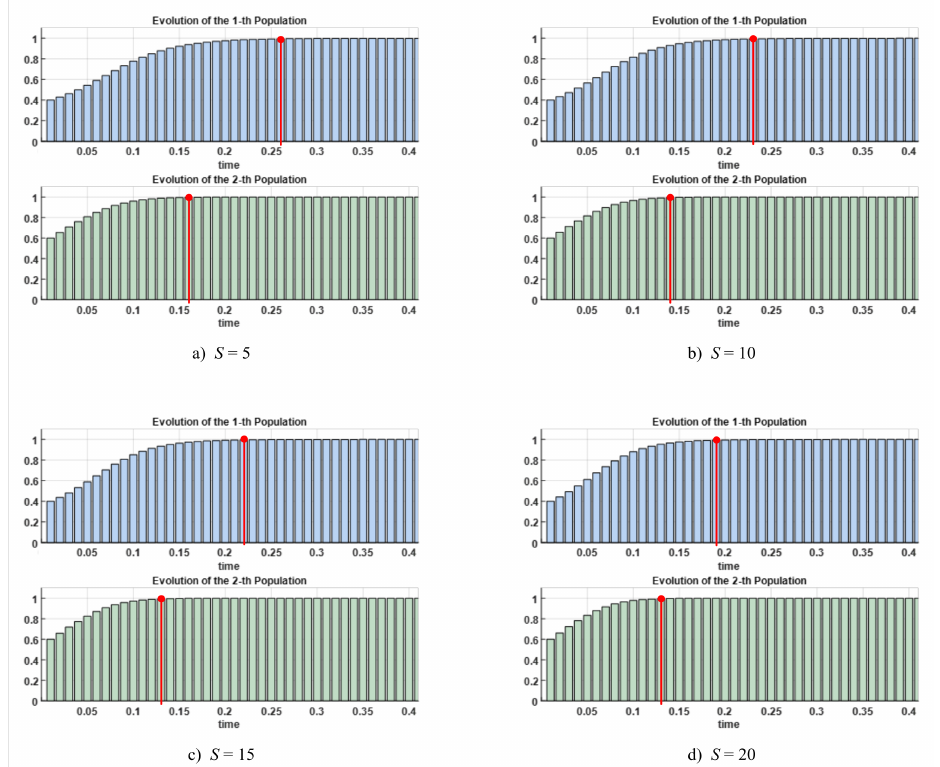
Figure 7. Influence of S change on system